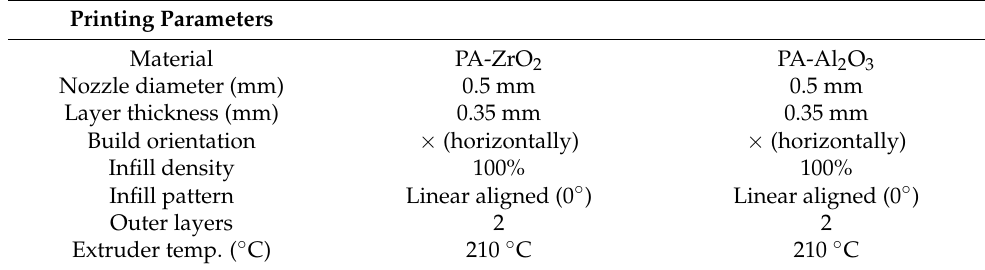
Table 2. Processing parameters of the soaking test samples.